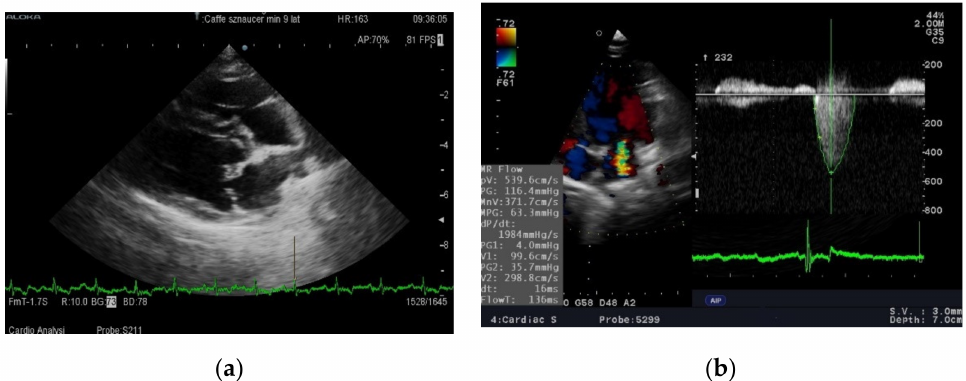
Figure 1. Echocardiographic examination of a dog with MMVD ( a ) 4th right intercostal space, long axis four chamber view. Tips of the mitral leaflet are thickened and deformed by degenerative processes—arrow. ( b ) On the left side of image is presented a multi-colored, turbulent jet of blood flowing back into the left atrium during systole. 5th left intercostal space, apical four-chamber view. On the right side—measurement of mitral regurgitant flow using continous Doppler